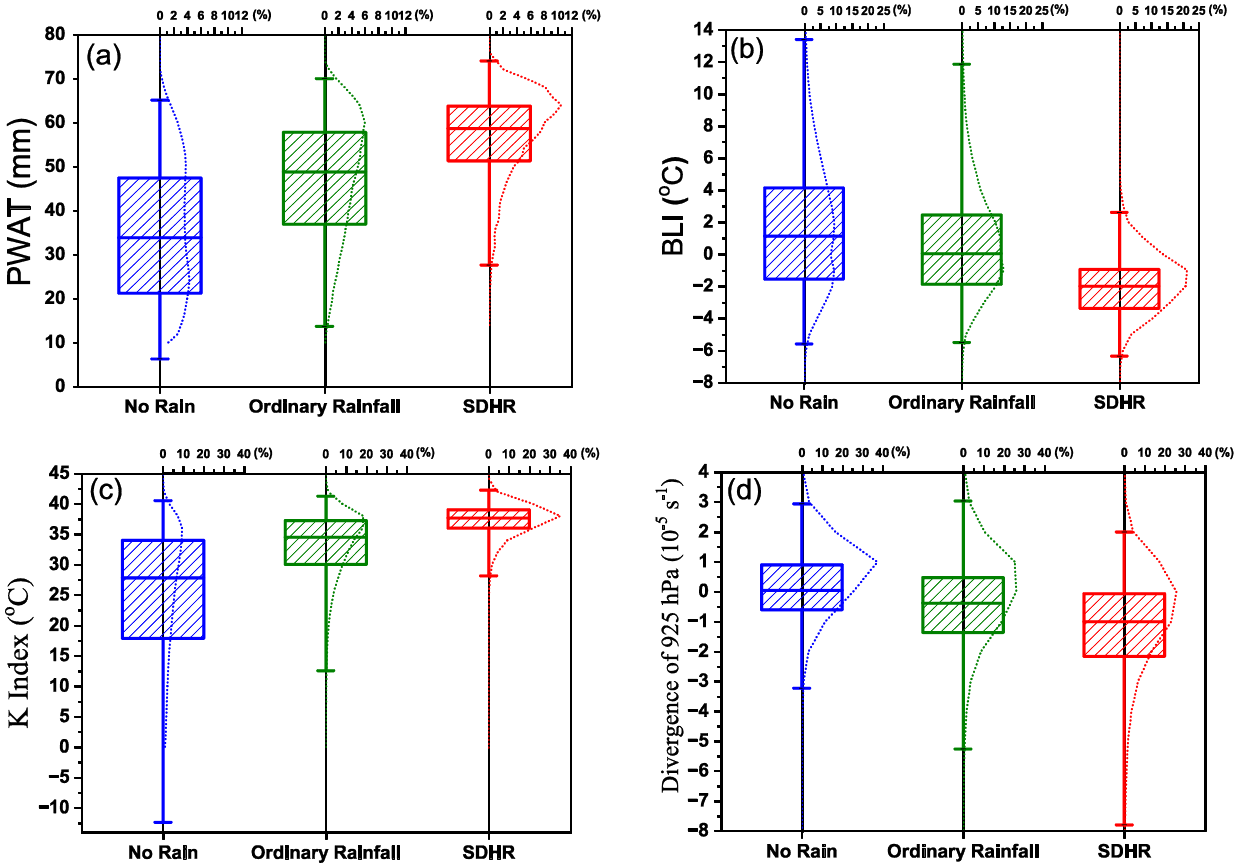
Figure 3. The box-and-whisker plots of ( a ) PWAT, ( b ) BLI, ( c ) KI, and ( d ) DIV 925 for no rainfall, ordinary rainfall, and SDHR. The three lines of the boxes indicate the 25th, 50th, and 75th percentiles. The upper and lower short bars indicate the 1st and 99th percentiles, respectively. The dashed lines with calibrations at the upper level show the distribution of the corresponding relative frequencies of the samples.